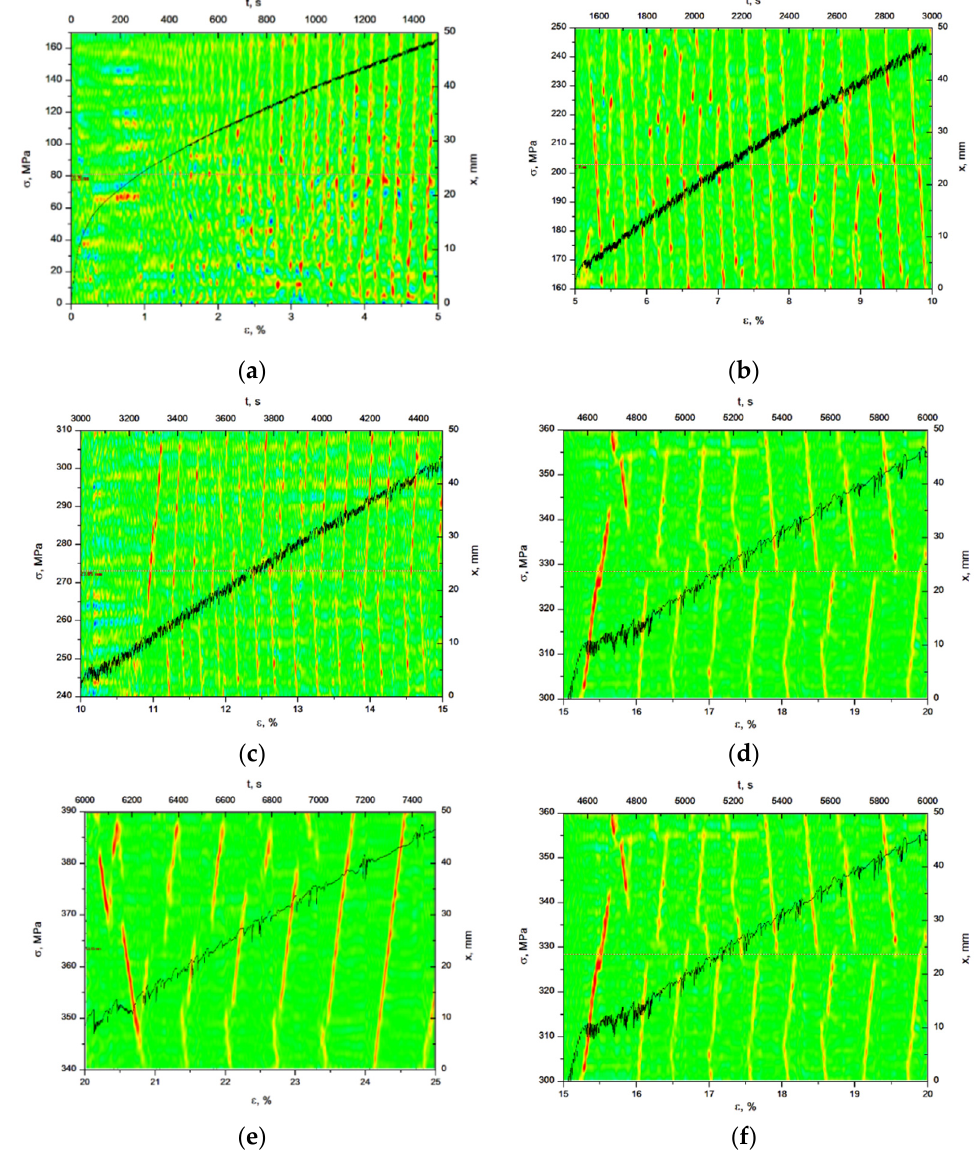
Figure 3. Sections from the stress–strain curve σ ( ε ) superposed with kinetic X-t diagrams of the motion of the PLC bands at the total deformation of: ( a ) 0–5%; ( b ) 5–10%; ( c ) 10–15%; ( d ) 15–20%; ( e ) 20–25%; ( f )